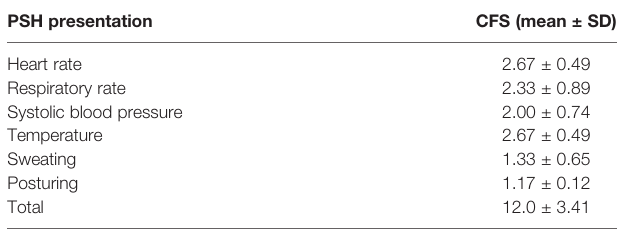
TABLE 2 | The CFS score of PSH in PSH (+) group.